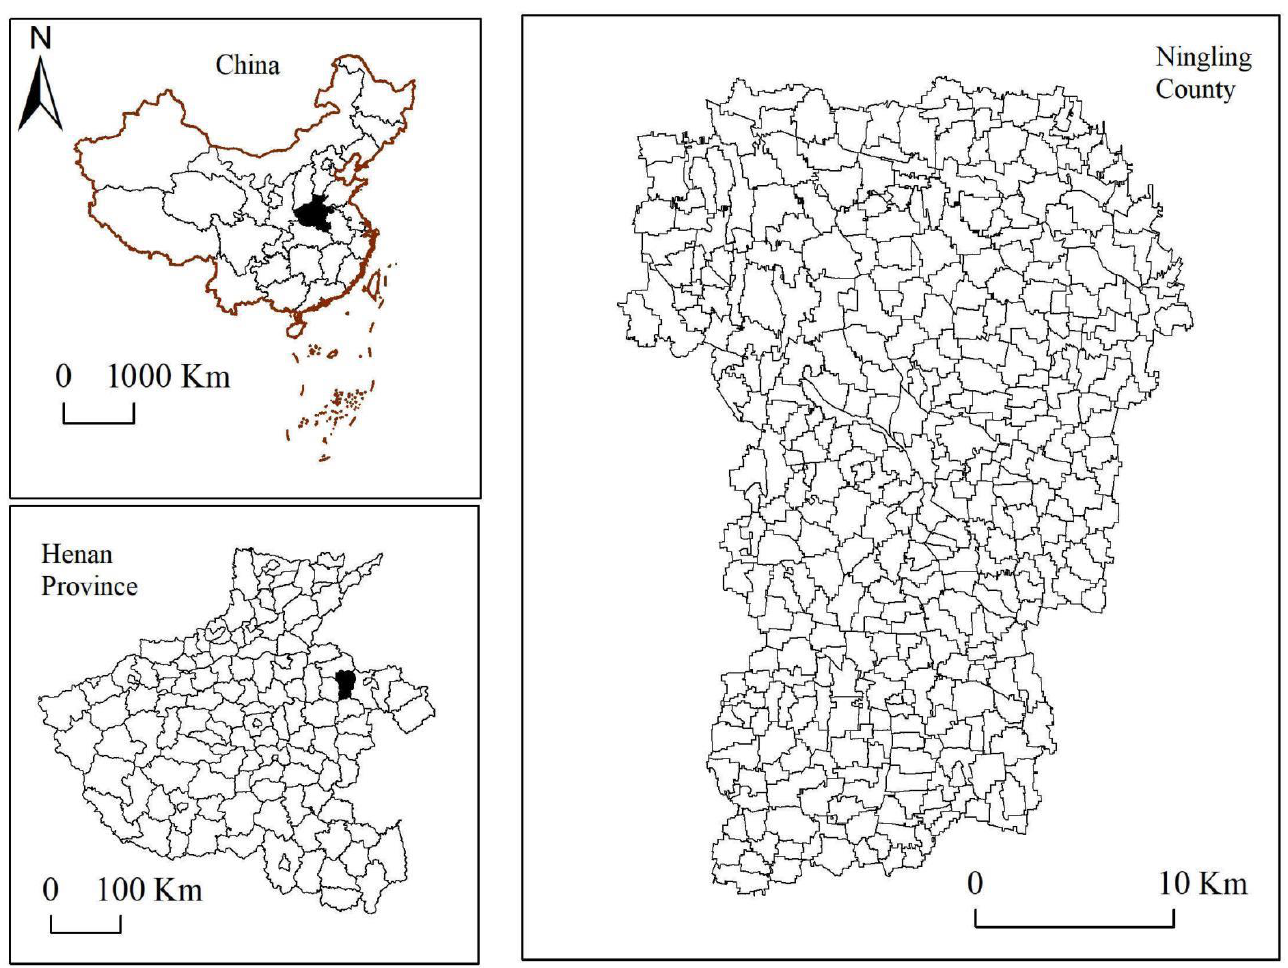
Figure 2. Location of Ningling